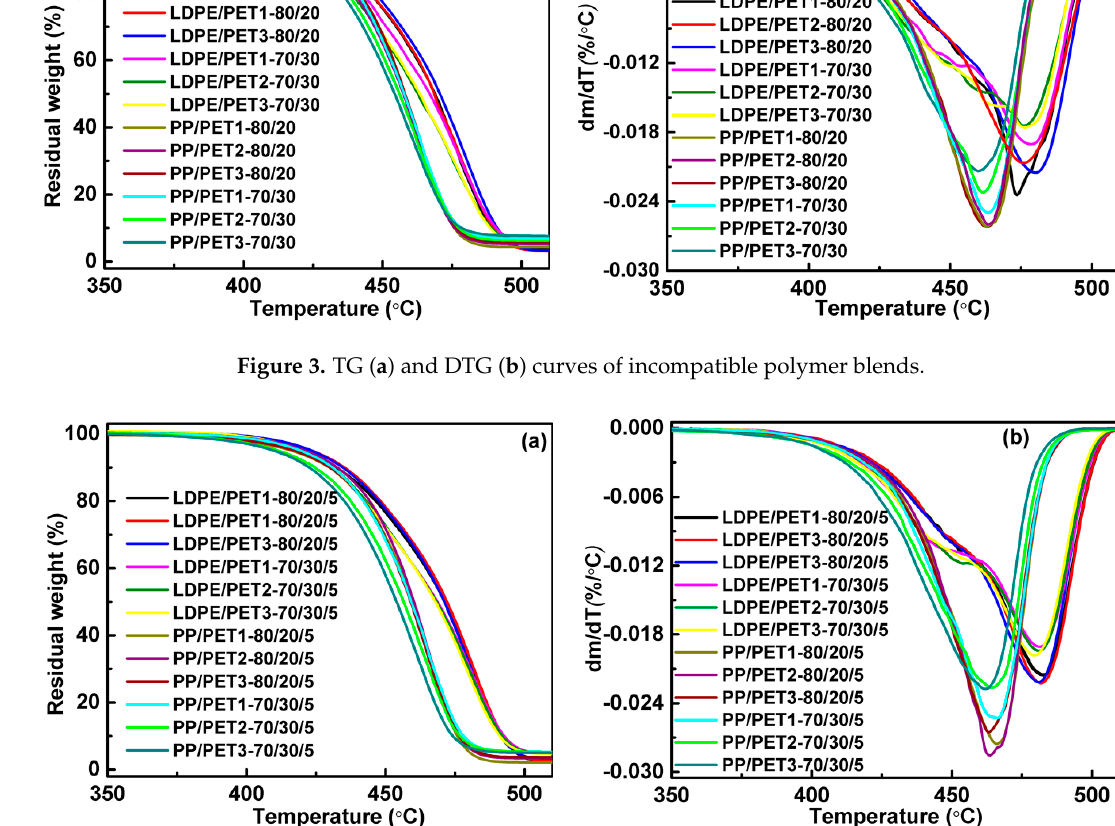
Figure 4. TG ( a ) and DTG ( b ) curves of compatibilized polymer blends. Table 4. The decomposition temperature ( T 5% ) and the corresponding temperature of the maximum decomposition rate ( T cmax ) of polymer blends.